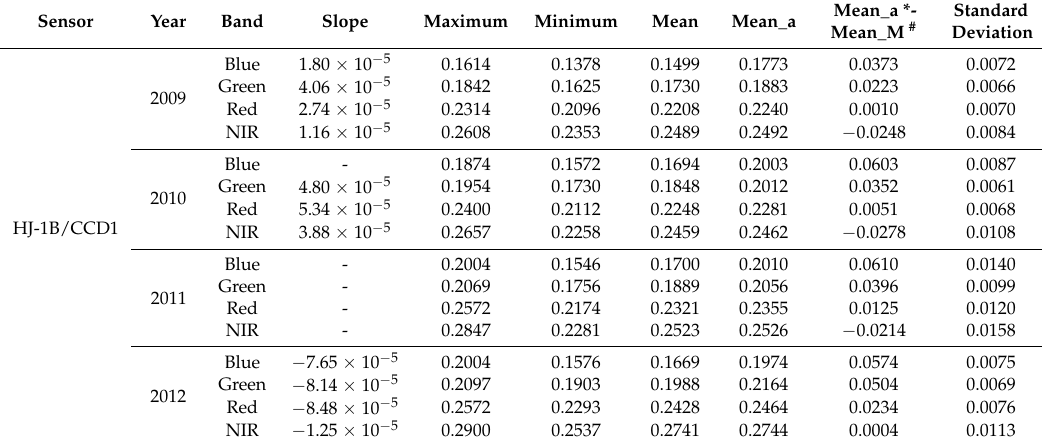
Table 10. The statistics from the time series of the TOA reflectances of HJ-1B/CCD1. Sensor